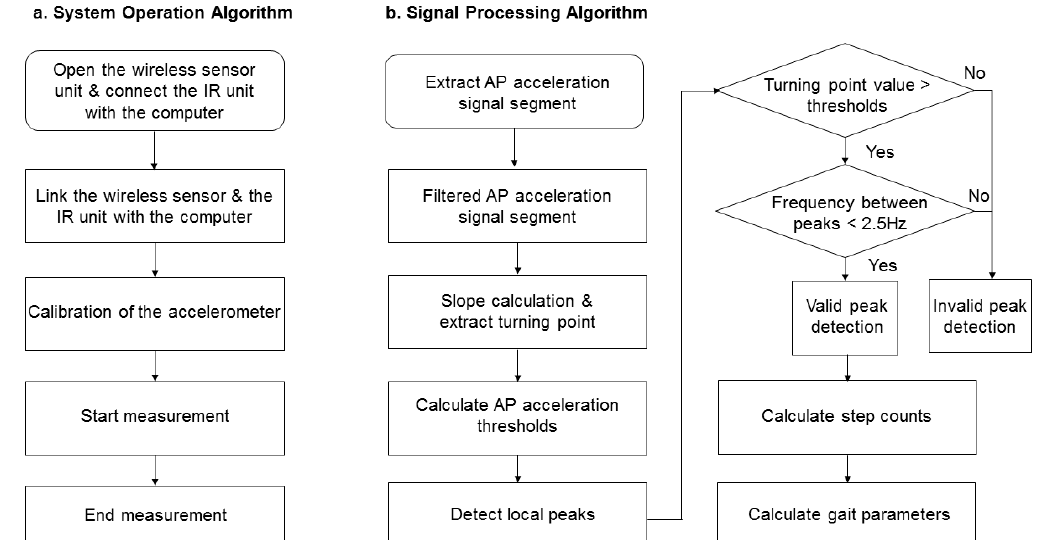
Figure 4. Flowchart of the system operation algorithm ( a ) and acceleration signal-processing algorithm ( b ). AP, anterior-posterior.